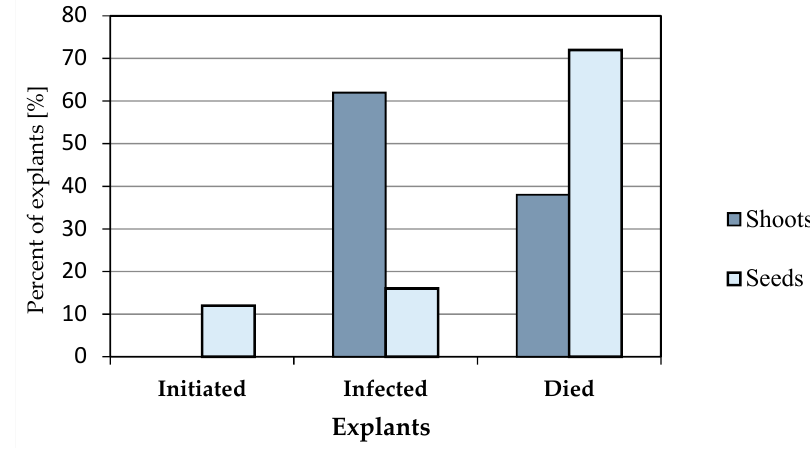
Figure 3. Percentage of explants [%] initiating growth, infected, and dead.